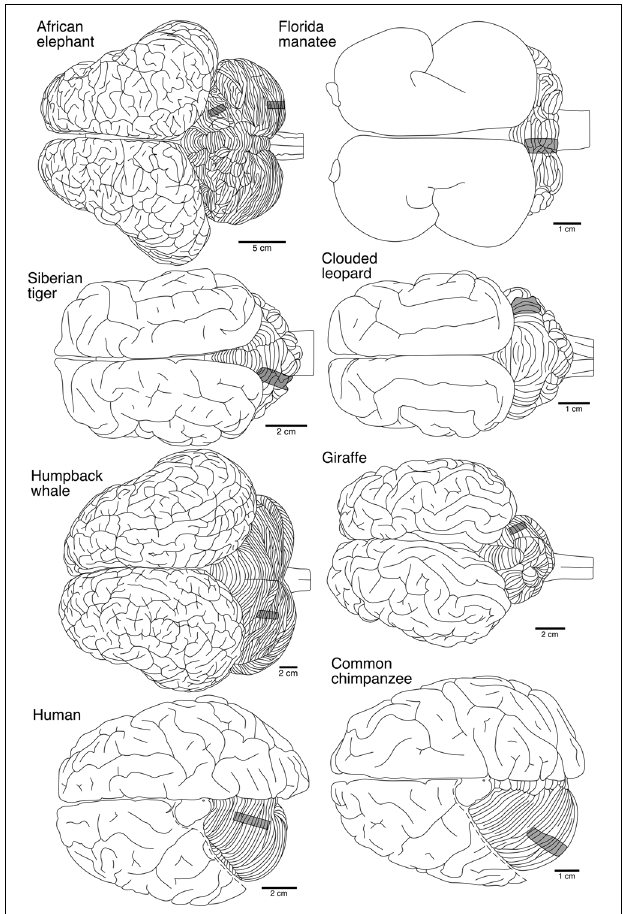
FIGURE 1 | Dorsal views of the brains from the eight species in the current study illustrating the relative location from which tissue blocks were selected from the cerebellum for staining. Represented from top to bottom are: afrotherians (African elephant, Florida manatee), carnivores (Siberian tiger, clouded leopard), cetartiodactyls (humpback whale, giraffe), and primates (human, common chimpanzee). For the two primates, the dorsal portion of the cerebrum has been removed to reveal the cerebellum. Note scale bar is different for each